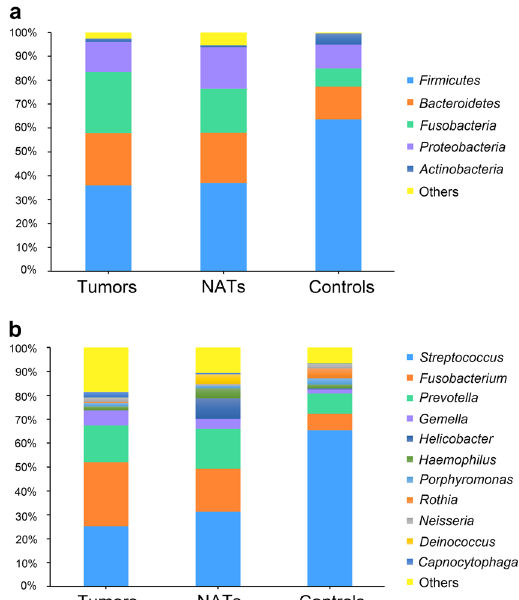
Figure 1. Abundances of dominant bacterial communities in the larynx. ( a ) Abundances (% of total 16S rRNA sequences) of the predominant bacterial phyla in the tumor tissue samples and the normal tissues adjacent to tumor sites (NATs) from laryngeal carcinoma patients, and in control tissue samples from vocal cord polyps subjects. ( b ) The Main bacterial genera in the laryngeal mucosa of the three groups of